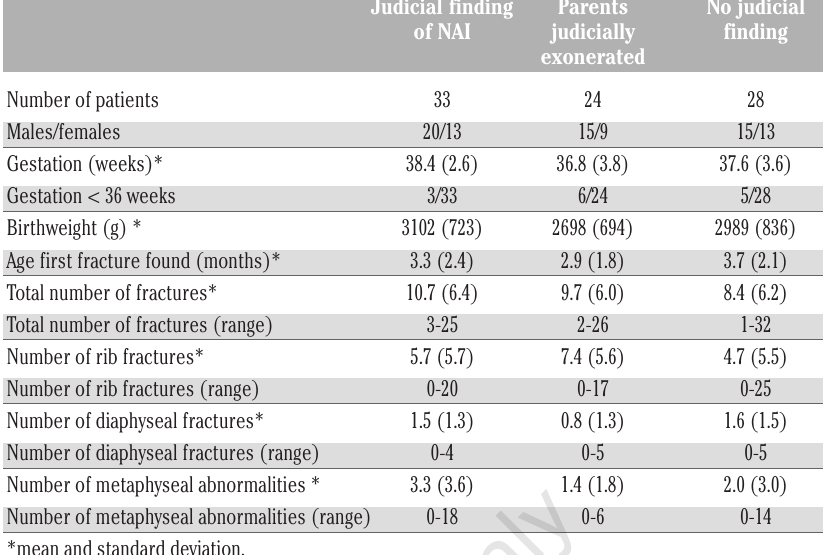
Table 1. Demographic details and clinical findings in the three groups of